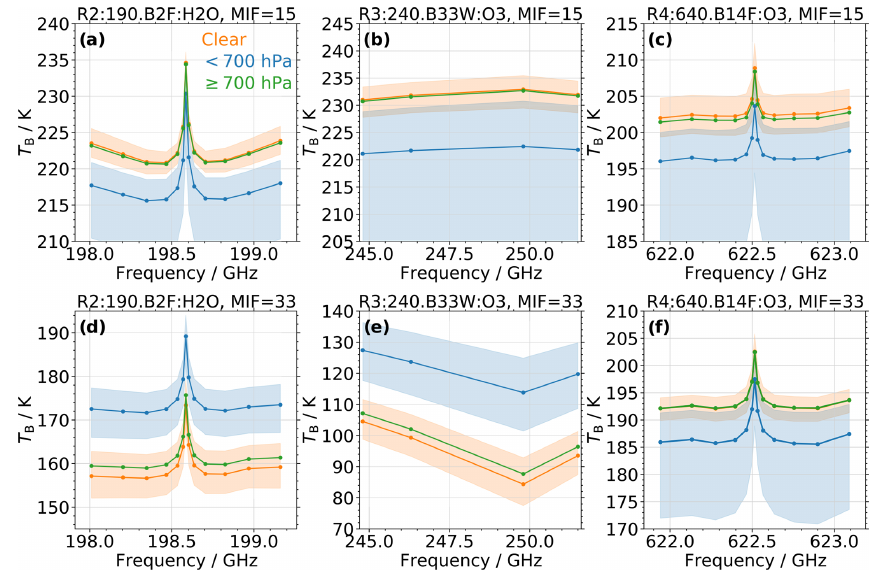
Figure 3. (a) Statistic of the brightness temperature ( T B ) from MLS observations sampled in band 2 of receiver 2 at minor frame (MIF) 15 (at an altitude of ∼ 4.5km) in the latitudinal range of − 30 to + 30 ◦ as a function of frequency. The orange, blue, and green curves show the median T B associated with clear-sky conditions, clouds with a cloud top pressure p CT < 700hPa, and clouds with p CT ≥ 700hPa, respectively. The orange- and blue-shaded areas indicate the interquartile range of the respective T B (omitted for low clouds to enhance legibility). Samples are provided by the colocated MLS–MODIS data set. (b) Same as (a) but for band 33 of radiometer 3. (c) Same as (a) but for band 14 of radiometer 4. (d–f) Same as (a–c) but at MIF = 33 (at an altitude of ∼